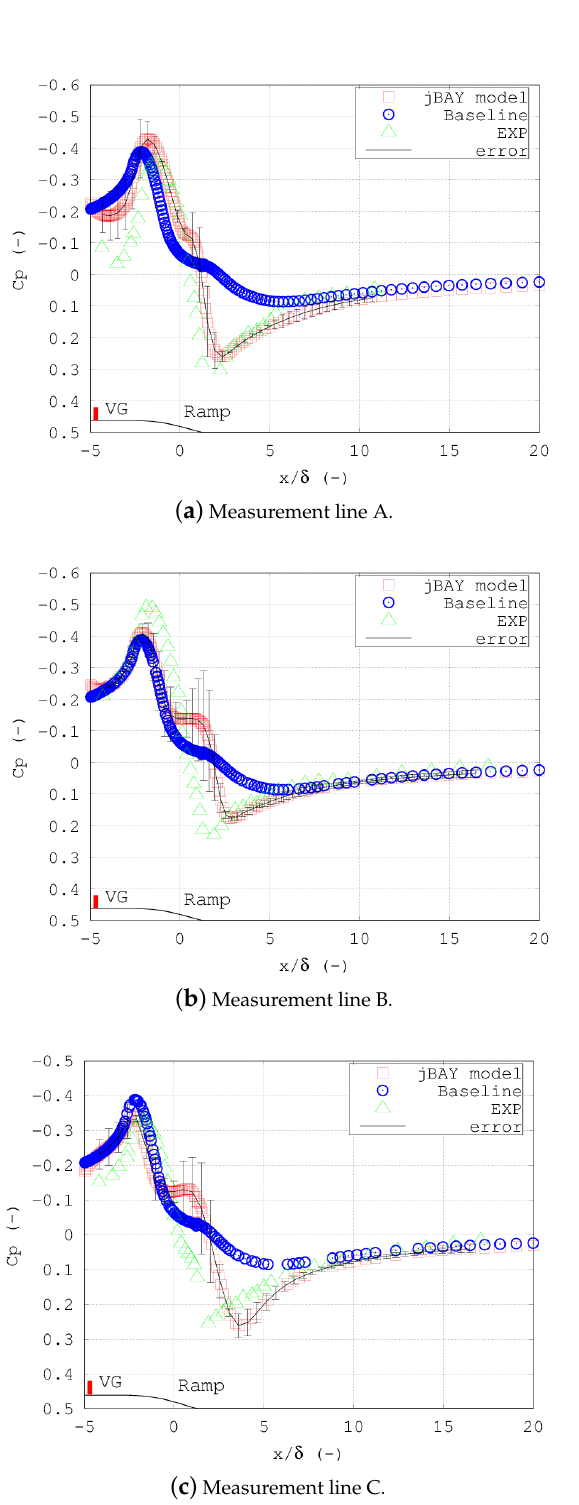
Figure 9. Streamwise pressure distribution c p along the measurement lines A, B and C on the flat plate floor. The red rectangles represent the simulated data (jBAY model), the blue circles the distribution data (Baseline) obtained from the baseline simulation and the green triangles the experimental (EXP) distribution data. Plots corresponding to the H 1 = 0.8 δ vane-type VG